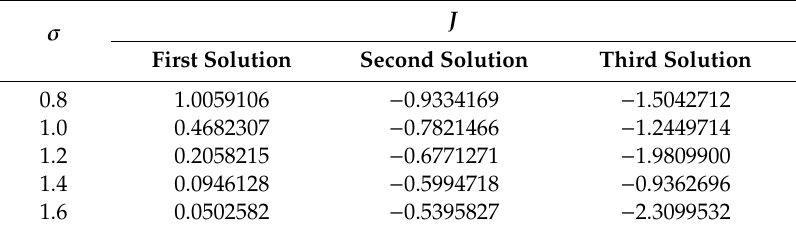
Table 4. Value of C fx Re 1/2 x and θ (cid:48) ( 0 ) as σ varies at Pr = 30, We = 0.2, n = 0.6, S = − 0.3 and M = 2.